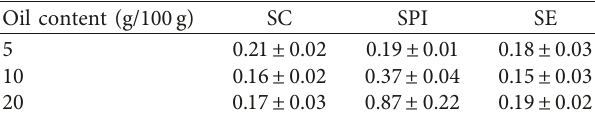
Table 3: Polydispersity index (PdI) of the emulsions stabilized by sodium caseinate (SC), soy protein isolate (SPI), and sugar ester (SE) with different oil contents homogenized at 20MPa.